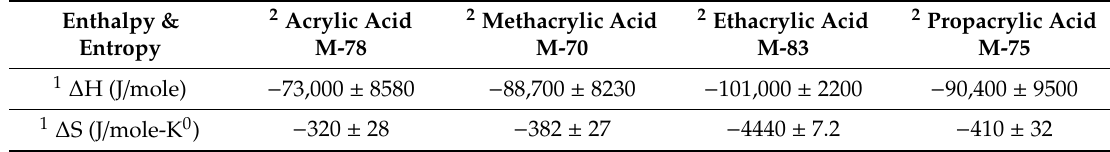
Table 3. ∆ H and ∆ S from pH-Induced Swelling of Four N -isopropylacrylamide Copolymers.